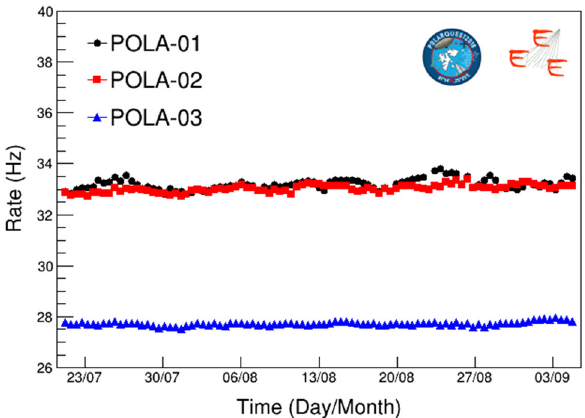
Fig. 23 Rates of cosmic particles measured by the three POLA detec- tors, corrected for the orientation (POLA-01) and pressure (POLA-01, POLA-02 and POLA-03) effects, as a function time since July 22, 2018